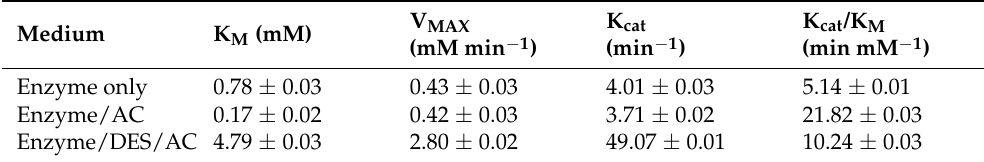
Table 2. Kinetic parameters of immobilized and free porcine lipase (PPL) in various reaction media using p NPP at different